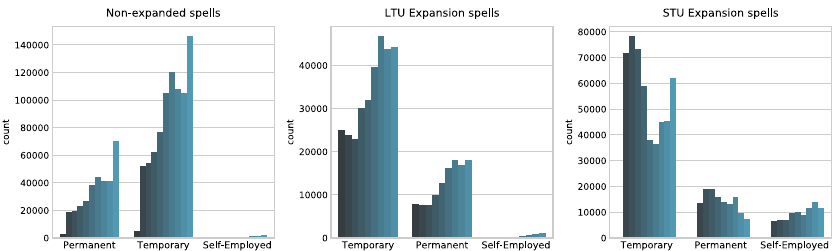
Fig. 24 Unemployment spells by expansion by year. Notes Each bar represents a year, from 2004 to 2013 (both inclusive). Raw number of unemployment spells, by unemployment expansion and contract type